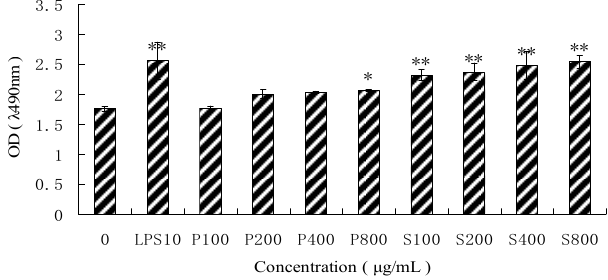
Figure 2. The different concentration of PPM60-D and SPPM60-D effect on RAW264.7 cell Figure 2. The di ff erent concentration of PPM60-D and SPPM60-D e ff ect on RAW264.7 cell proliferation proliferation ( n = 6). Note: * p < 0.05, ** p < 0.01 compared with the control. ( n = 6). Note: * p < 0.05, ** p < 0.01 compared with the control.